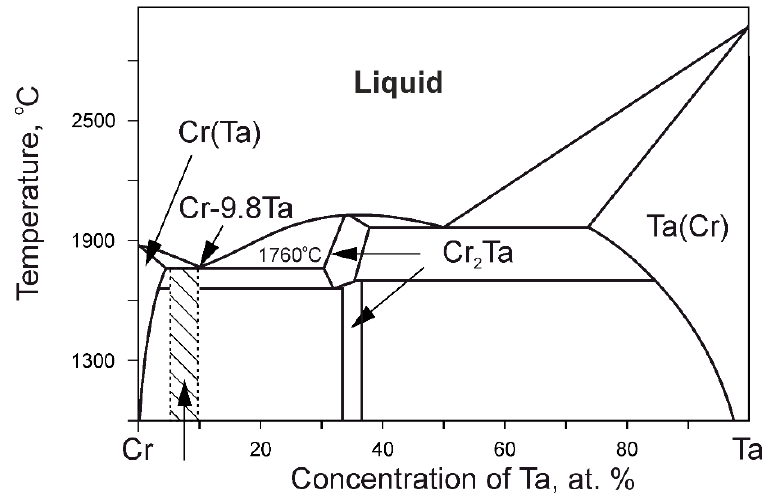
Figure 4. Cr ‐ Ta binary alloy schematic phase diagram. Taken from Ref. [12] with permission from ASM. Copyright 1986, ASM.